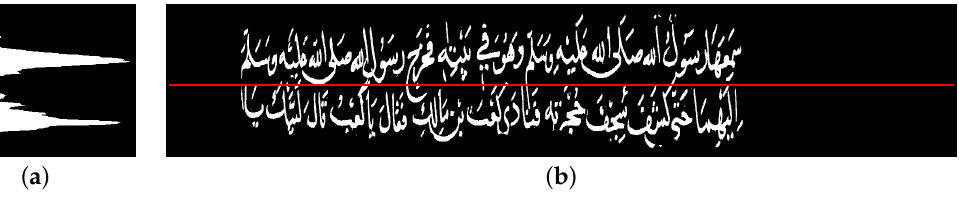
Figure 6. Splitting combined lines: ( a ) the horizontal profile of an image patch, and ( b ) the mask is split at the minima closest to the center of the mask. The split line is shown in